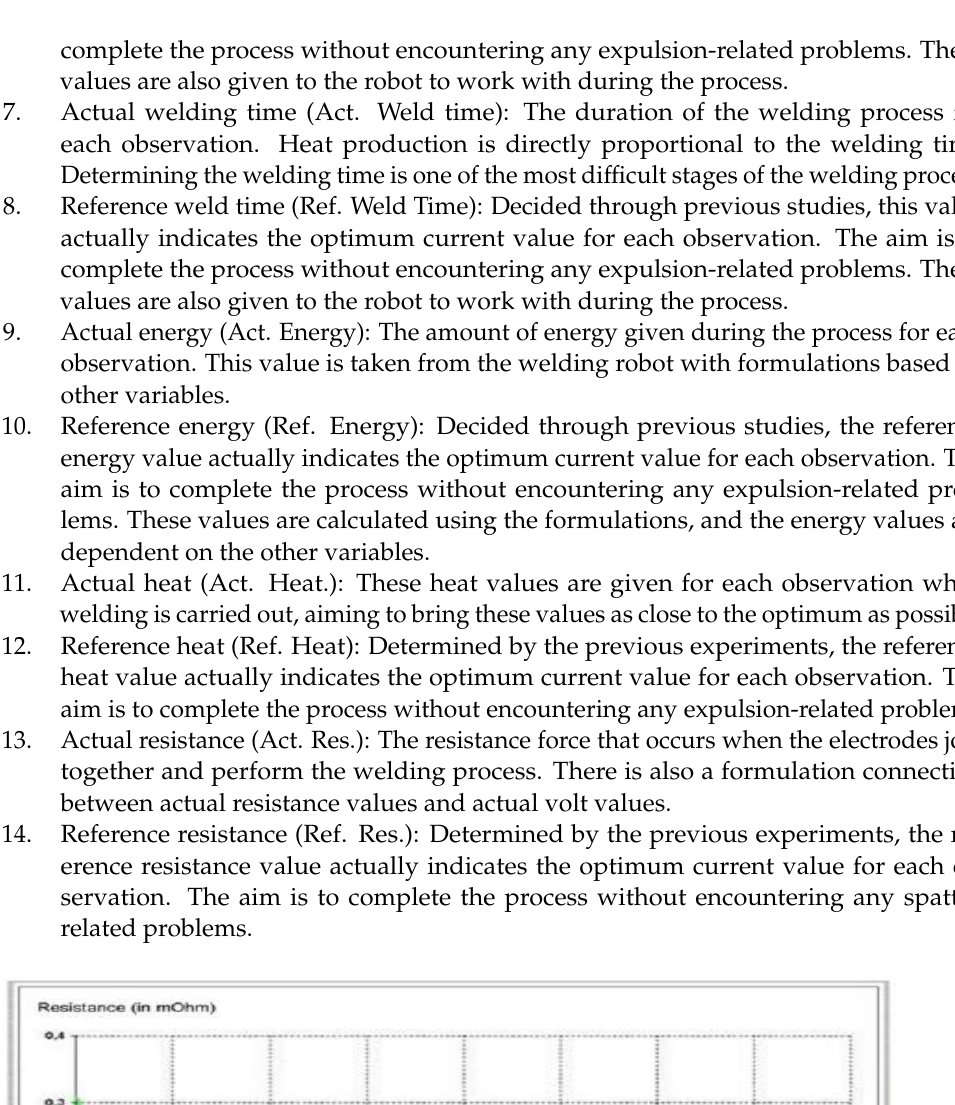
Table 2. Raw variables as candidate features for spot welding parameter prediction.